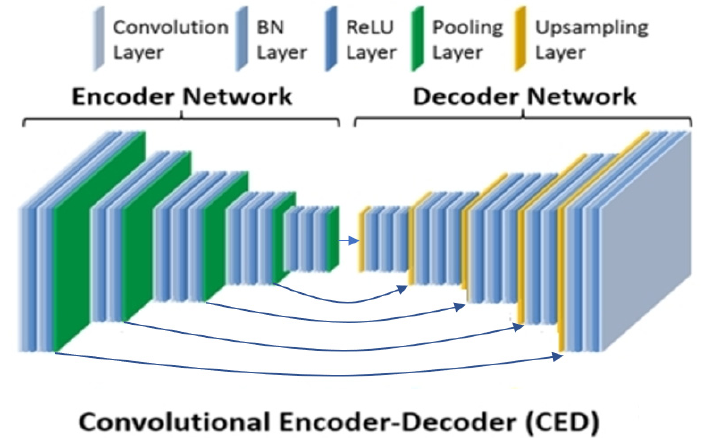
Figure 2. Example of data augmentation.